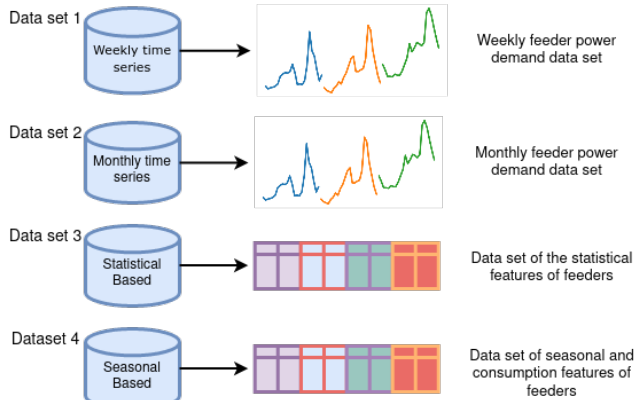
Figure 4. The four data sets that were formed from the hourly electricity consumption records of the